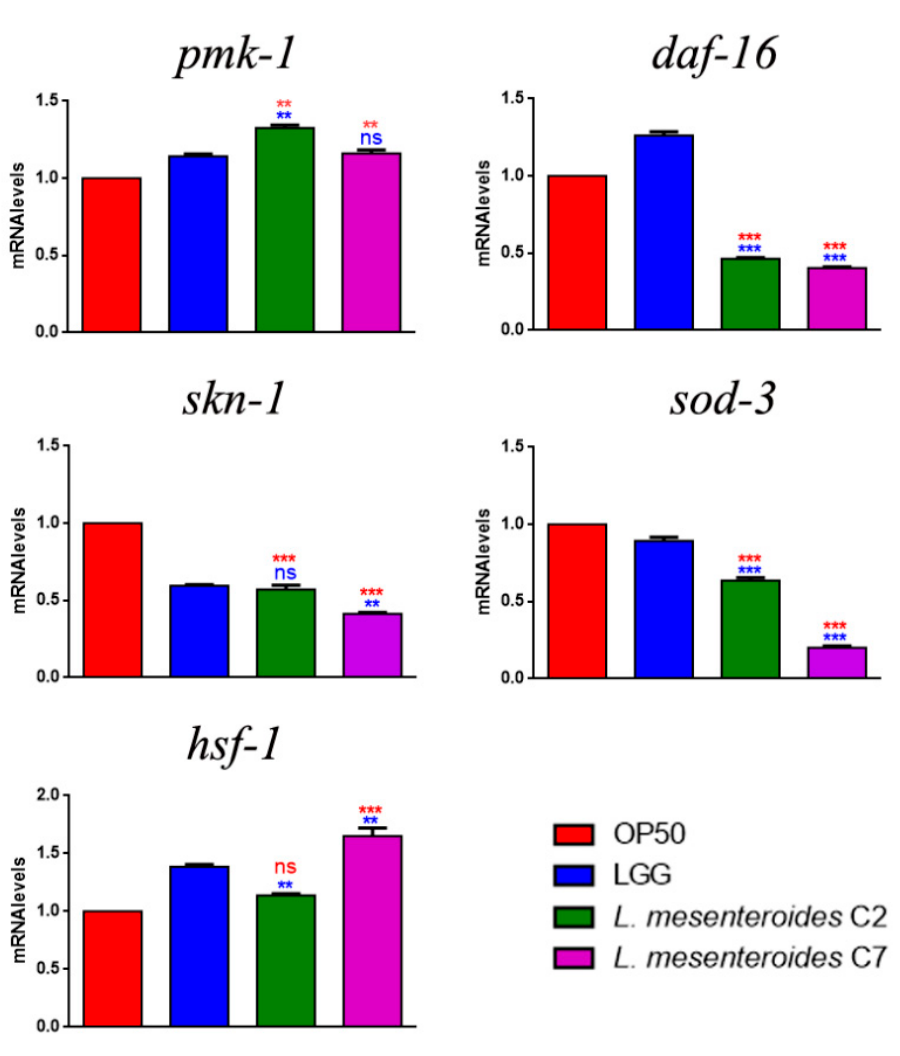
Figure 5. Transcript levels of genes involved in C. elegans immunity. Expression of pmk-1 , skn-1 , sod-3 , daf-16 and hsf-1 genes in 1-day-old adults fed with different bacterial strains. Experiments were performed in triplicate. LGG (LAB reference strain) and OP50 were used as controls. Data are presented as mean ± SD. Asterisks indicate significant differences (** p < 0.01, *** p < 0.001) as compared to LGG (blue asterisks) or OP50 (red asterisks) controls; ns: not significant.